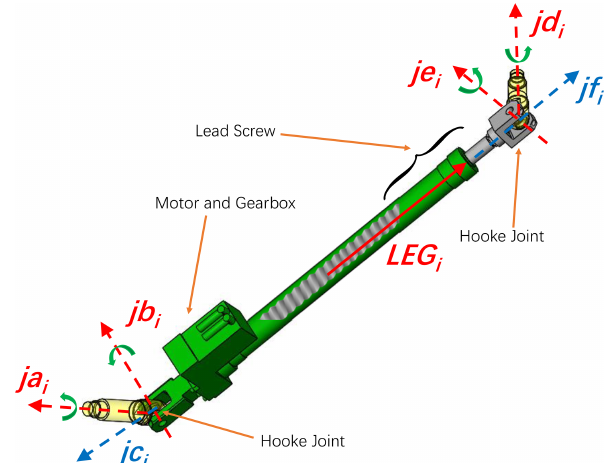
Figure 2. Driven branch chain and joint